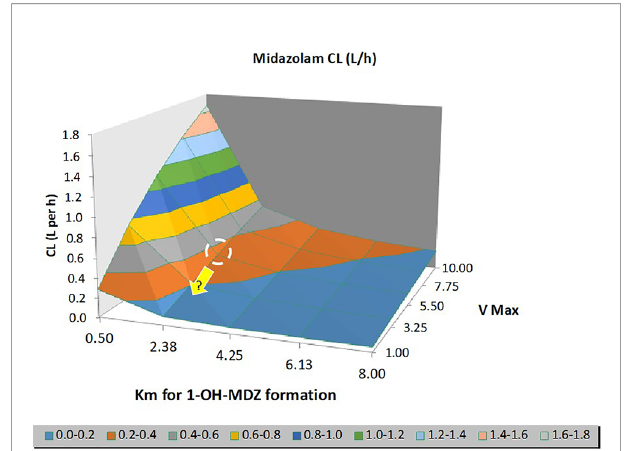
FIGURE 5 | Output of a sensitivity analysis for midazolam clearance (CL) in neonates, illustrating the model-predicted impact of changes in Michaelis – Menten constant (K m ) and/or maximum reaction rate (V max ) describing the intrinsic formation CL of 1-OH midazolam by CYP3A4. The ‘ dashed' circle represents the V max /K m values at normothermia, while the yellow arrow indicates a plausible change in V max (rather than K m ) under conditions of hypothermia.